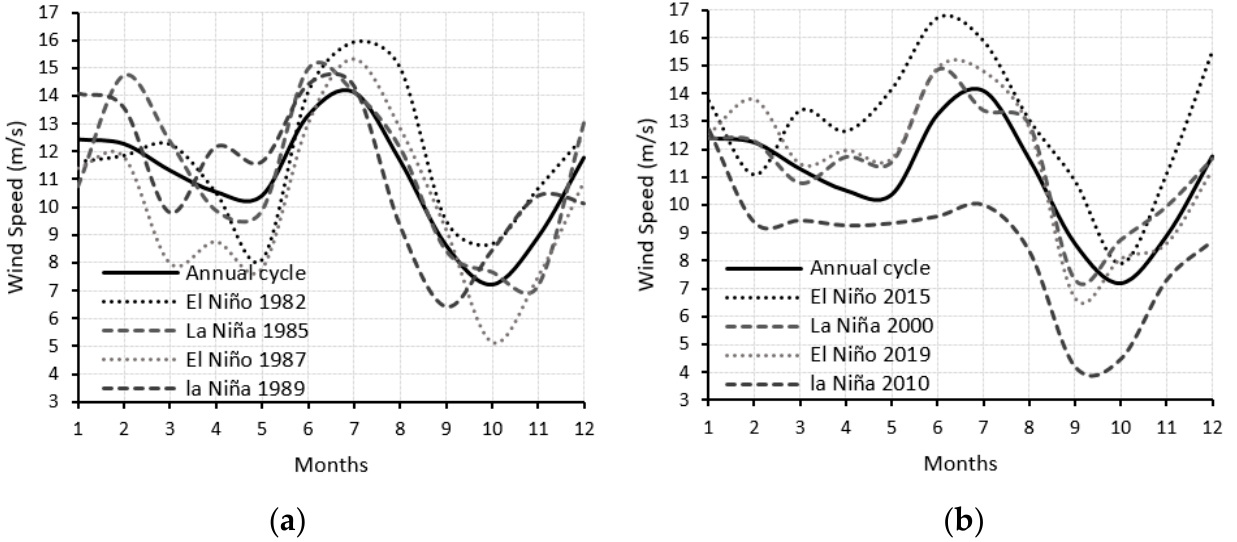
Figure 7. Wind Speed within the CLLJ area during several ENSO events. ( a ) Negative; ( b ) Positive phases of AMO.